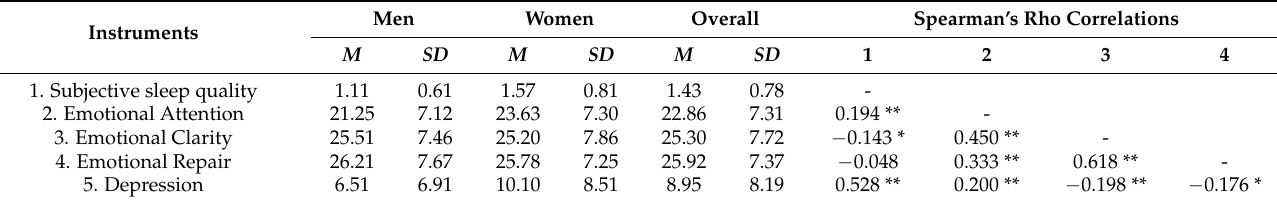
Table 1. Means, standard deviations and bivariate correlations between the study variables.